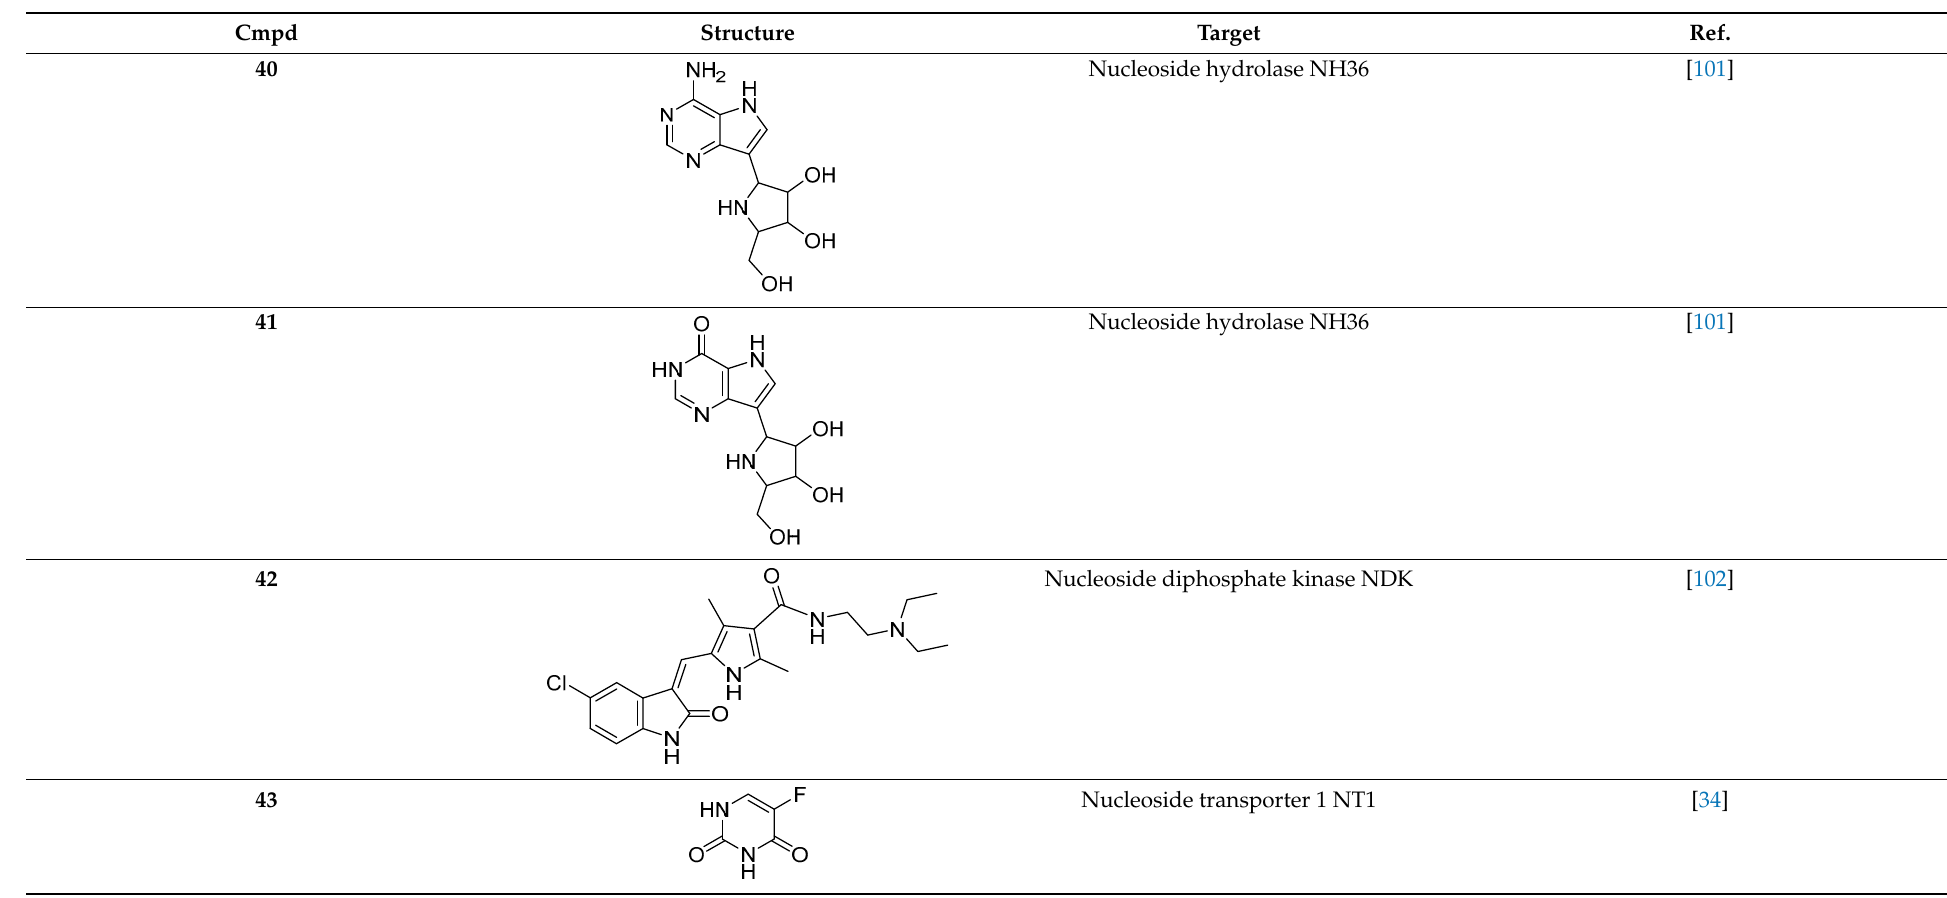
Table 5. Targets and related agents against Leishmaniases .